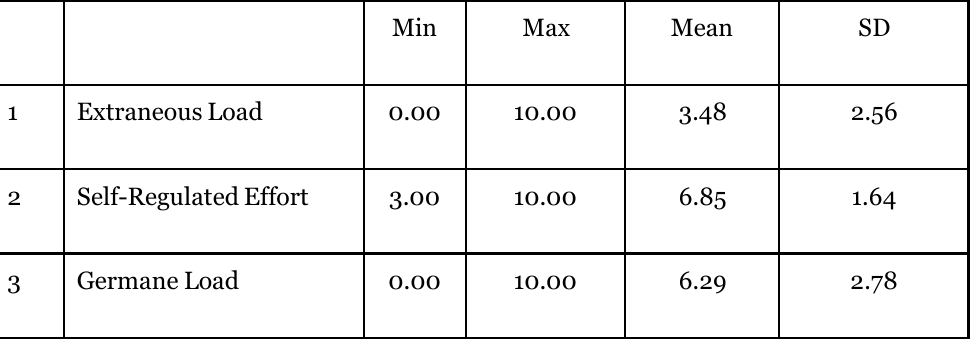
Means for Extraneous Load, Self-Regulated Effort, and Germane Load (N =